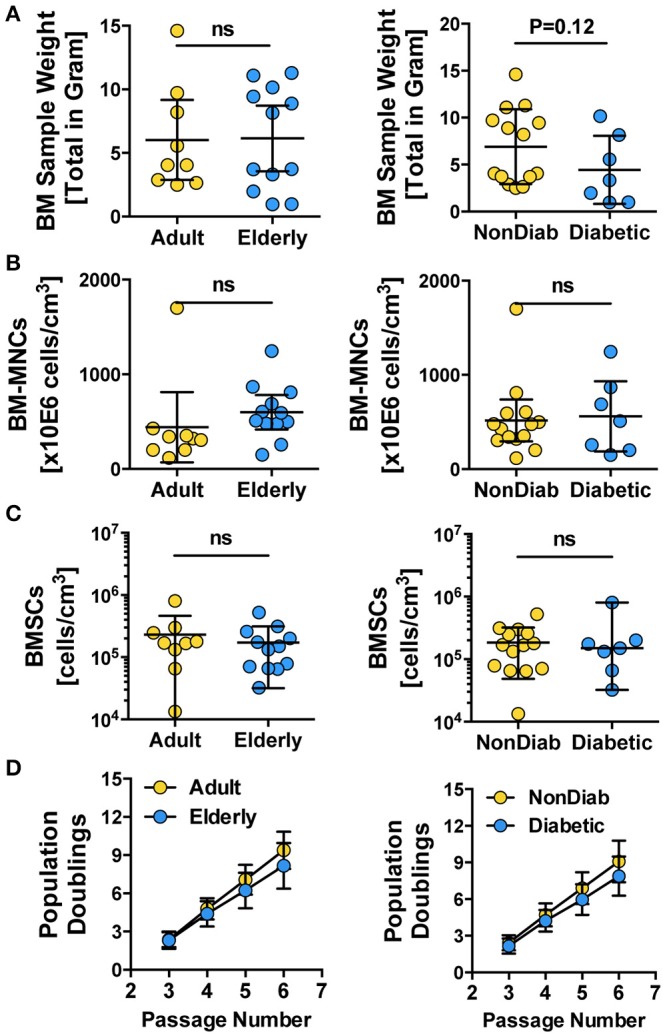
Primary isolation and growth kinetics of BMSCs. (A–C) Quality control of BM samples: (A) bone marrow sample weight (in grams) and (B) number of BM-MNCs per sample (cells/cm3), (C) number of BMSCs per sample (cells/cm3), and (D) growth kinetics of BMSCs, with population doublings determined at different passages (P3-6), were quantified for BMSC preparations from adult vs. elderly (n = 9 vs. 12) and for non-diabetic vs. predominantly non-insulin-dependent early-stage diabetic donors (n = 14 vs. n = 7). Data are shown as mean ± SD, and the statistics were evaluated with a Student's t-test.